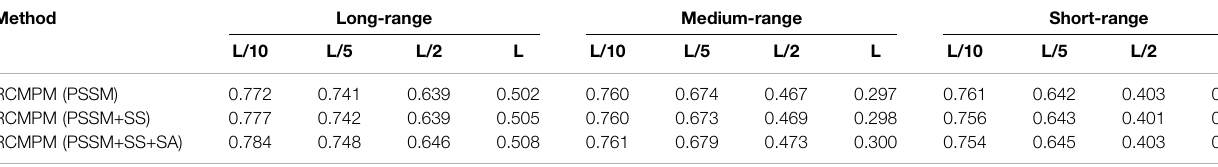
TABLE 6 | Comparison results for feature combinations by using the rough RaptorX-Contact contact map. Method